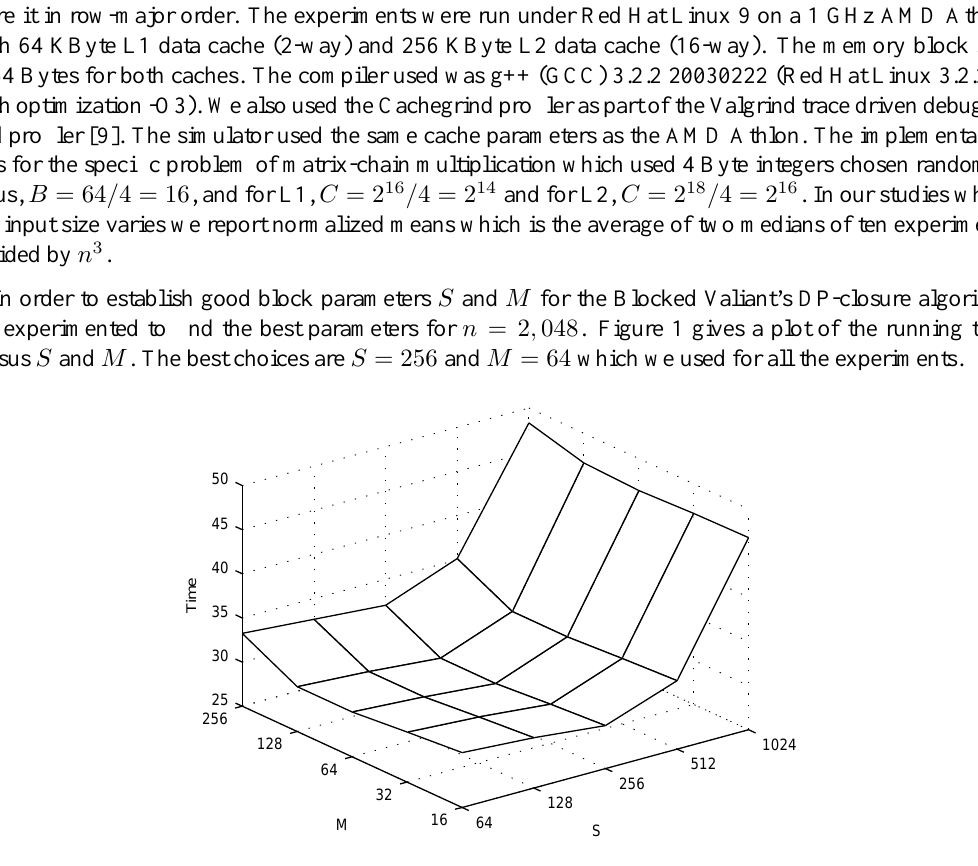
Fig. 1: Time in seconds are plotted as a function of the two block parameters S and M for inputs matrices of size